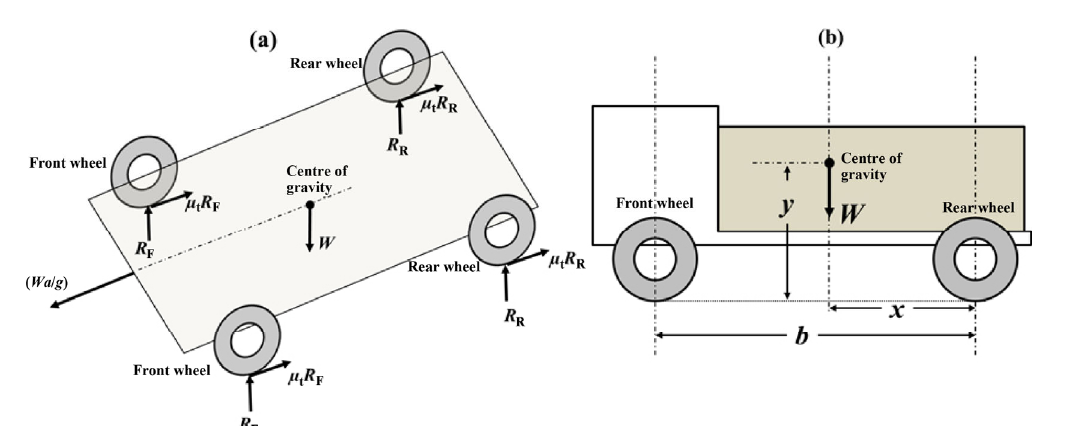
Fig. 13 (a) Braking efforts for a truck and (b) side view of a